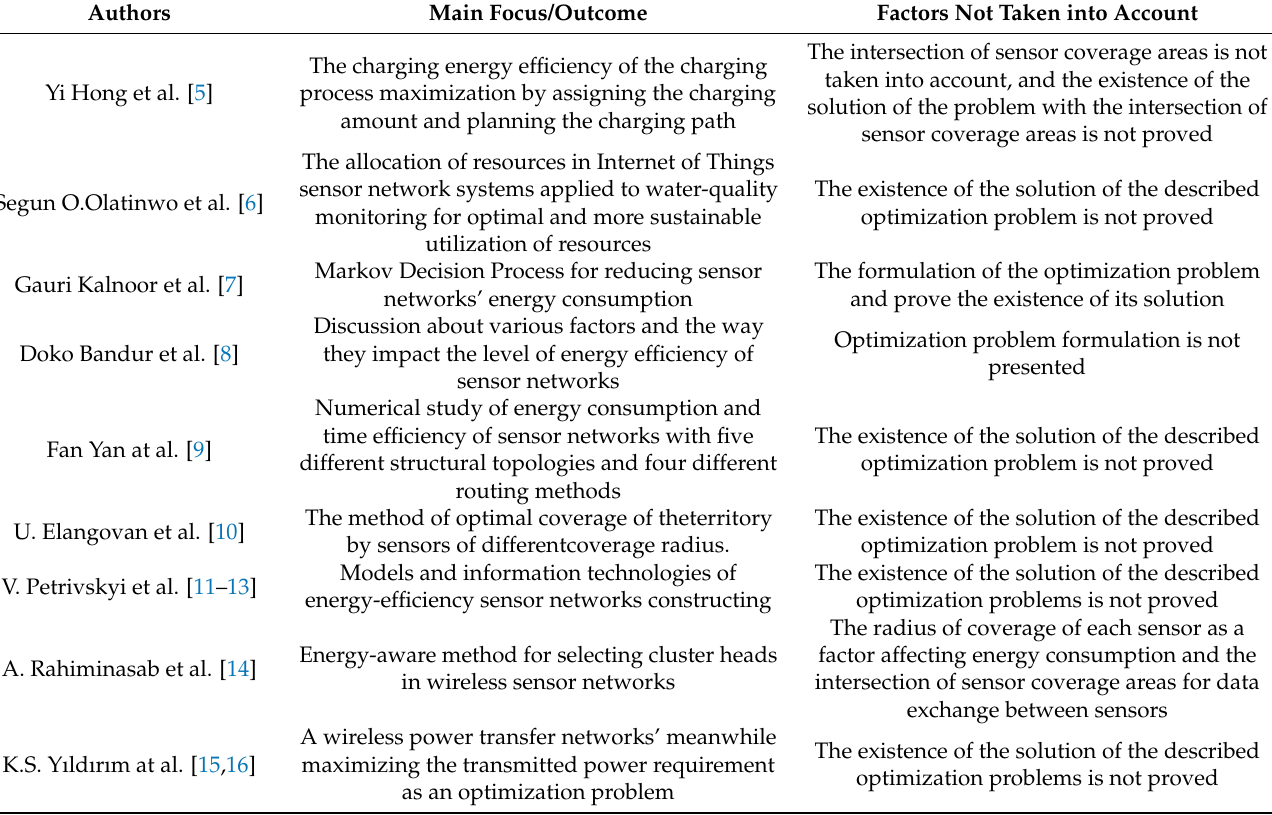
Table 1. Literature review